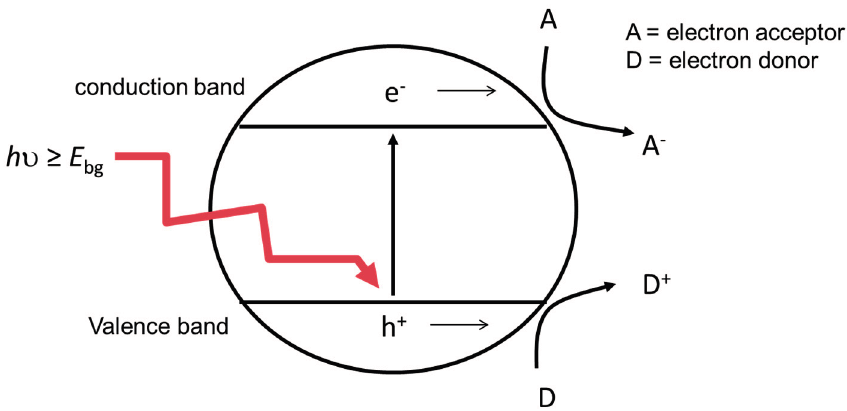
Figure 1. Schematic showing the basic mechanism of heterogeneous